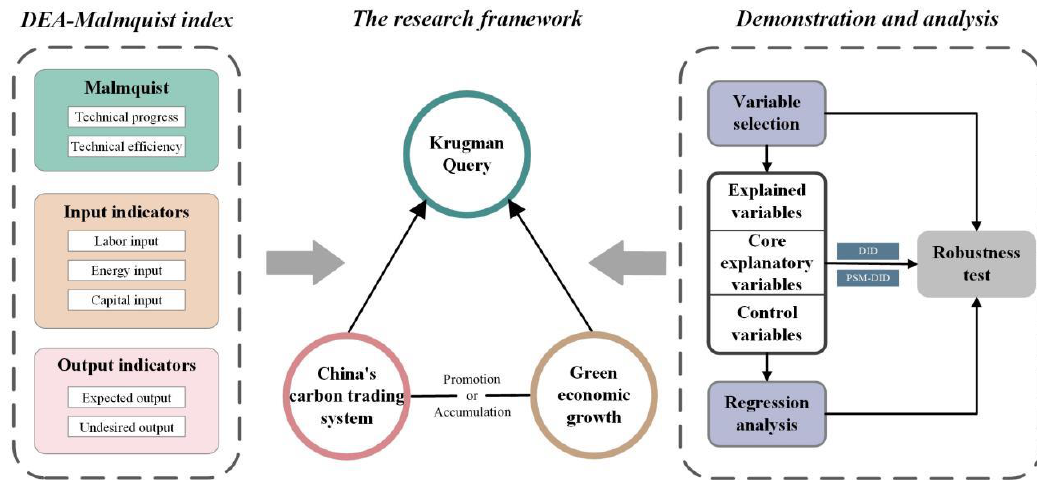
Figure 2. The overall research framework of the paper.